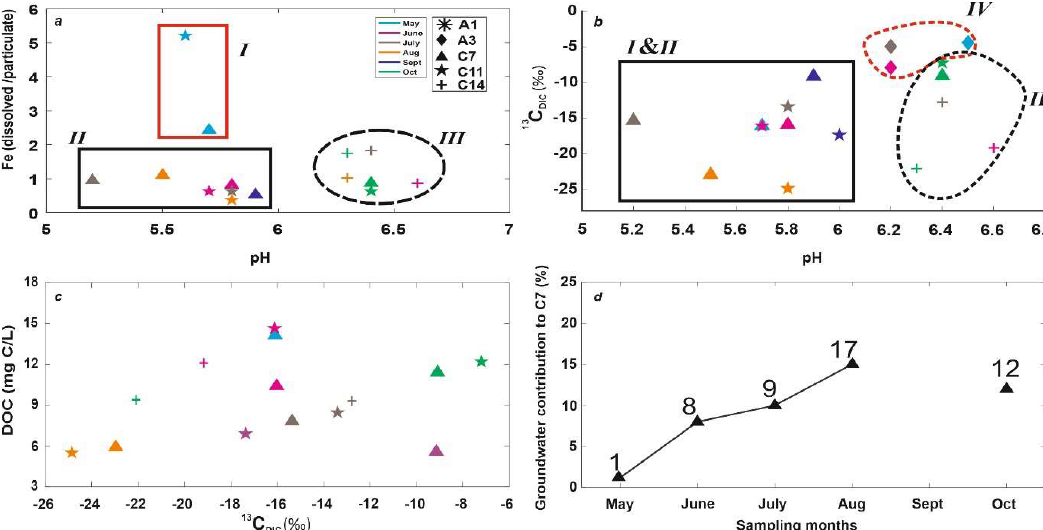
Figure 4. ( a ) pH versus dissolved/particulate Fe ratios of mixed surface waters: C7, C11 and C14 (from [15]). ( b ) pH versus δ 13 C DIC of ground water and mixed surface waters. ( c ) DOC versus δ 13 C DIC of the mixed surface waters. ( d ) Estimated monthly groundwater contribution to C7.